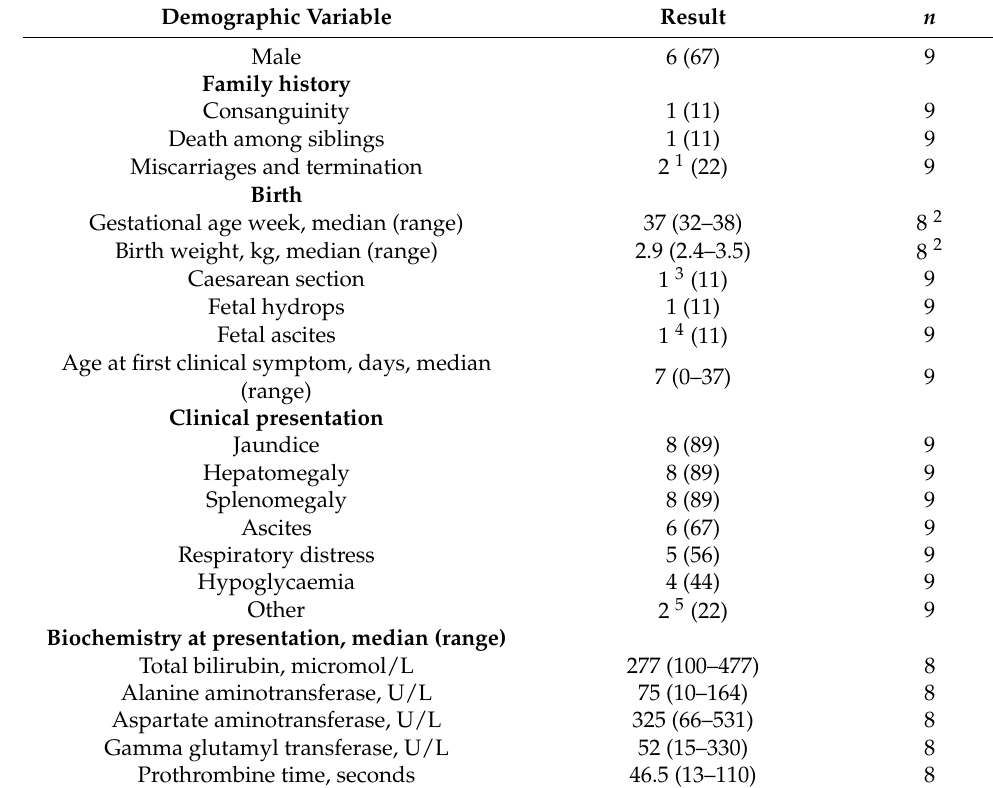
Table 1. Patient characteristics and clinical presentation of nine patients diagnosed with Niemann Pick type C who underwent liver transplantation between 2003 and